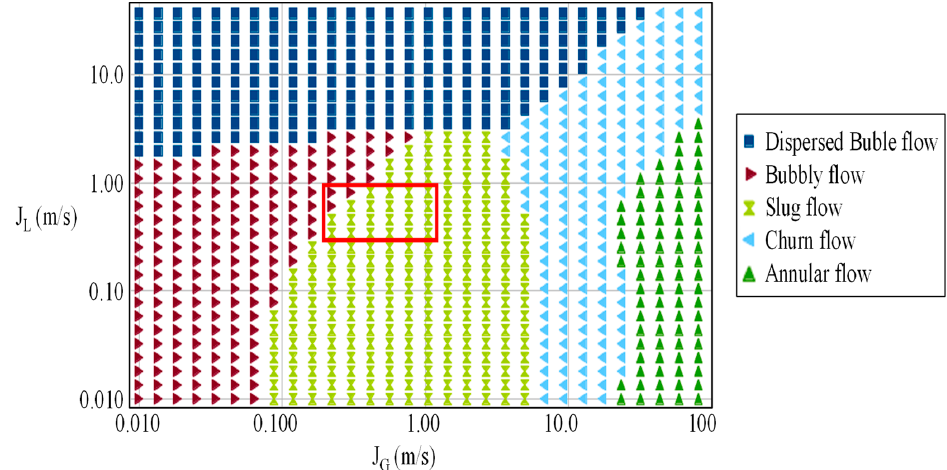
Figure 3. Flow map test setup for slug flow based on [17].